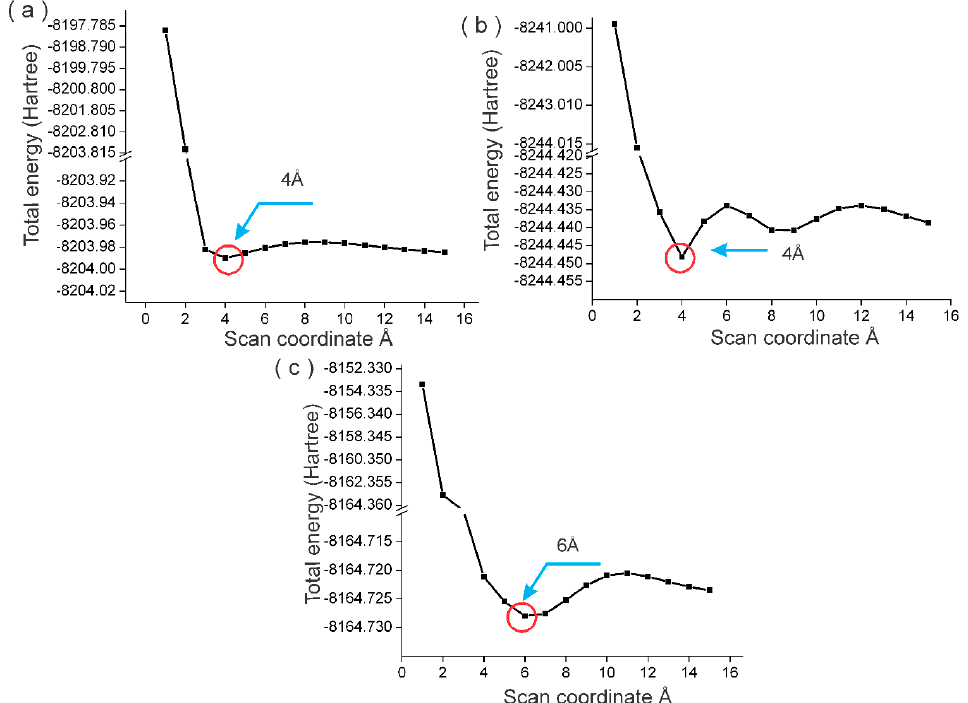
Figure 3. Energy curve of binding distance for ( a ) ND2HP and tamoxifen (TAM), ( b ) NPEG and TAM, and ( c ) NDPGA and TAM.